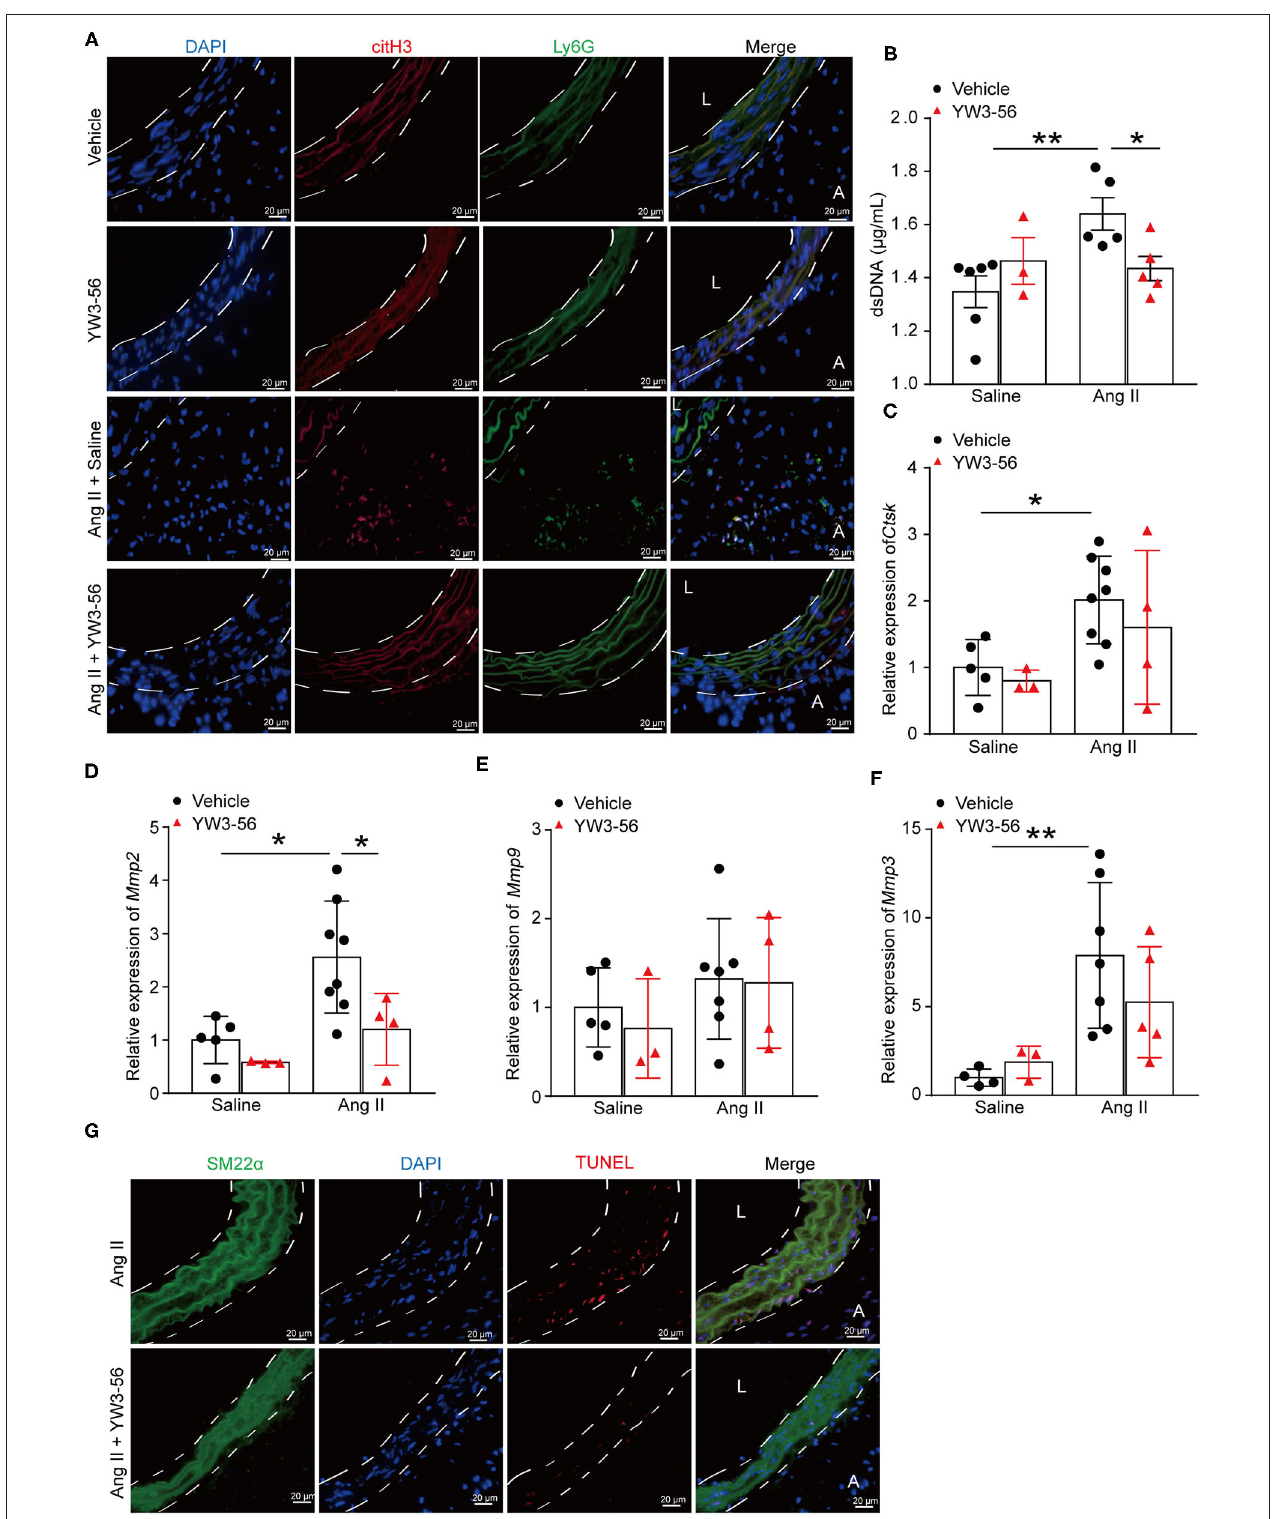
FIGURE 5 | PAD4 inhibitor YW3-56 reduced NET formation and VSMC apoptosis in Ang II-induced AAA. ApoE − / − mice were infused with saline or 1,000 ng/kg/min Ang II for 28 days in the presence of vehicle or YW3-56. (A) Immunofluorescence analysis for citH3 (red) and Ly6G (green) in the abdominal aortas. Nuclei